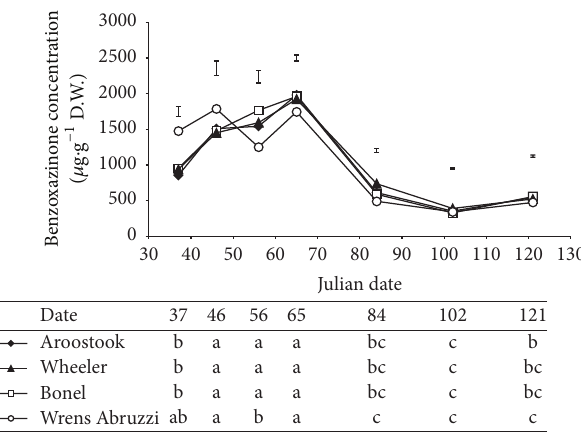
Figure 5: Variation of total benzoxazinone concentration (sum of DIBOA-glucoside, DIBOA, and BOA) in shoot tissue of four rye cultivars between dates 37 and 121 (Julian dates) during the first year of experiments. Significant differences over time within each variety according to the Tukey-Kramer method ( 𝑝 < 0.05 ) are indicated by different letters. Vertical bars represent standard errors at each sampling date.